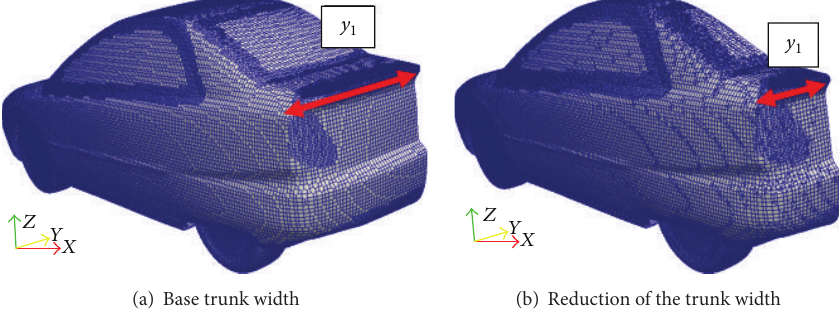
Figure 18: Variation of the trunk width (parameter 𝑦 1 ).